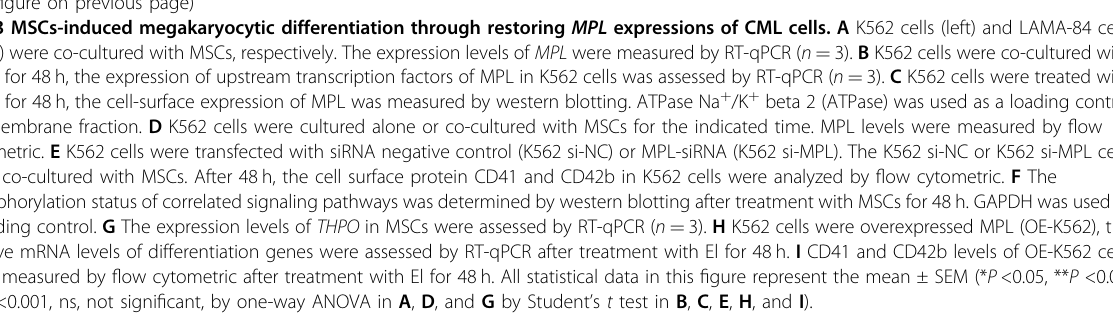
serum starvation, we found that megakaryocytic differ- entiation genes expressions were markedly upregulated (Fig. S5D). On the other hand, MSCs-induced mega- karyocytic differentiation of K562 cells was attenuated by